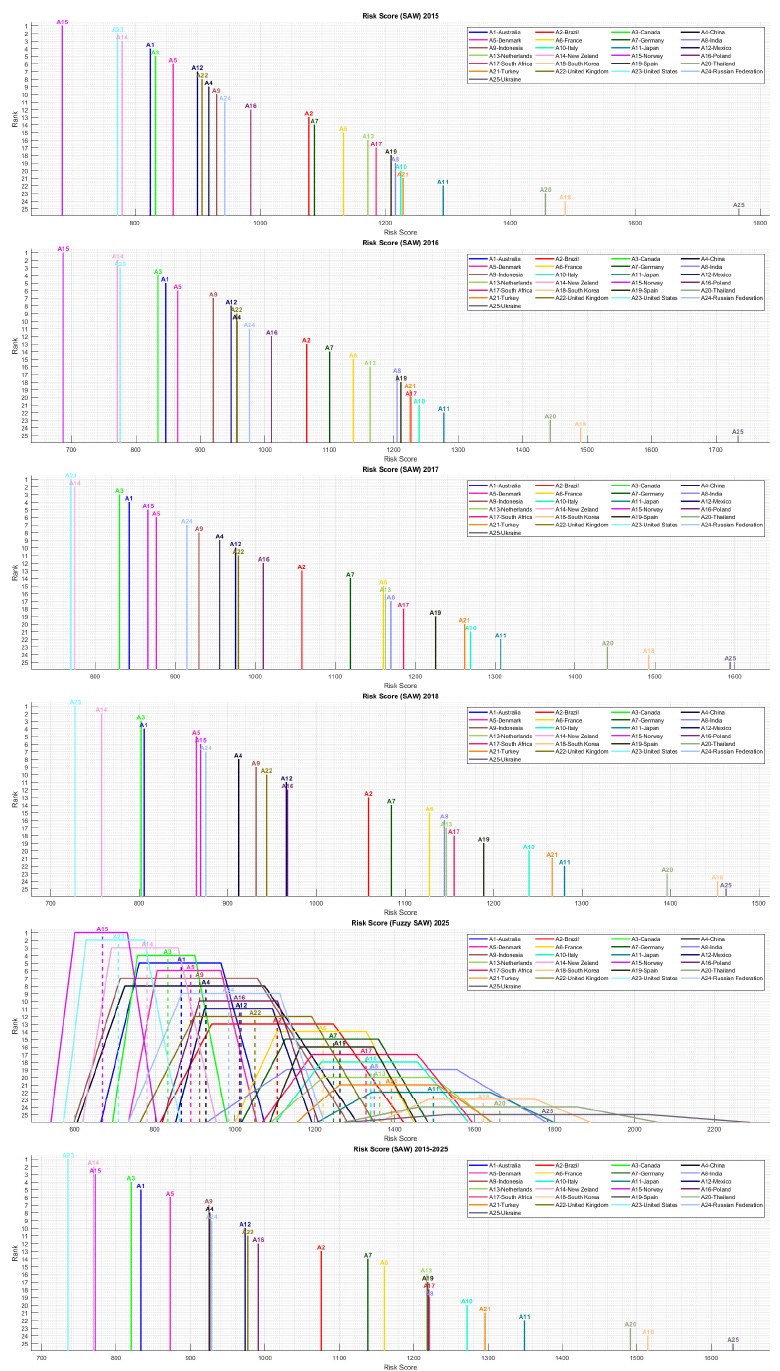
Figure 1. Energy security rankings in the periods 2015–2025 based on the SAW methodology.